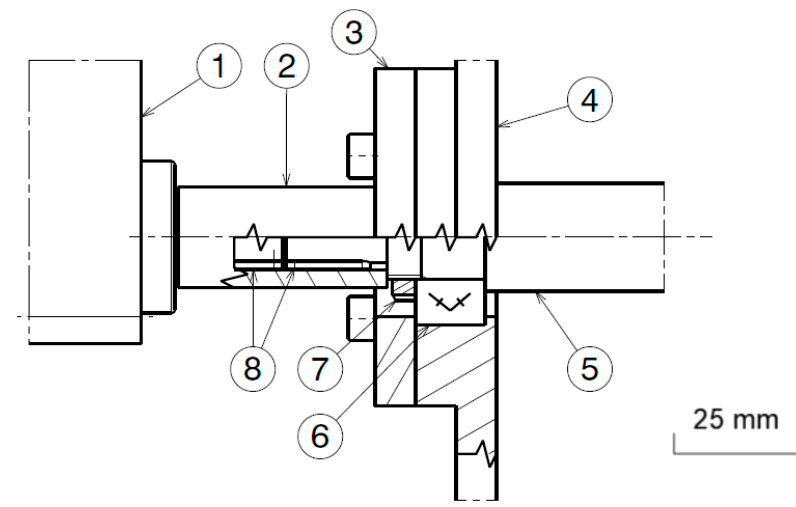
Figure 6. Drawing of the transmission system: (1) motor; (2) rigid coupling; (3) cover plate; (4) lateral plate; (5) spindle; (6) bearing; (7) nut; (8) keys.